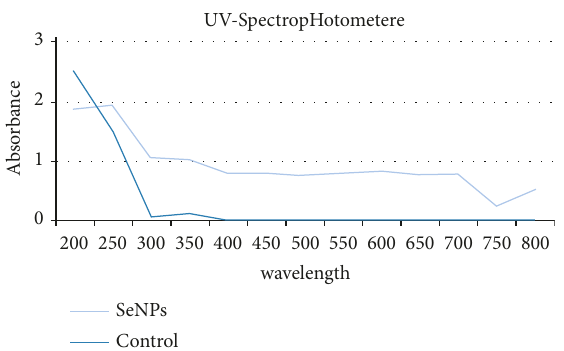
Figure 3: Control sample has not shown any absorption changes while at 275nm SeNPs showed sharp peak.